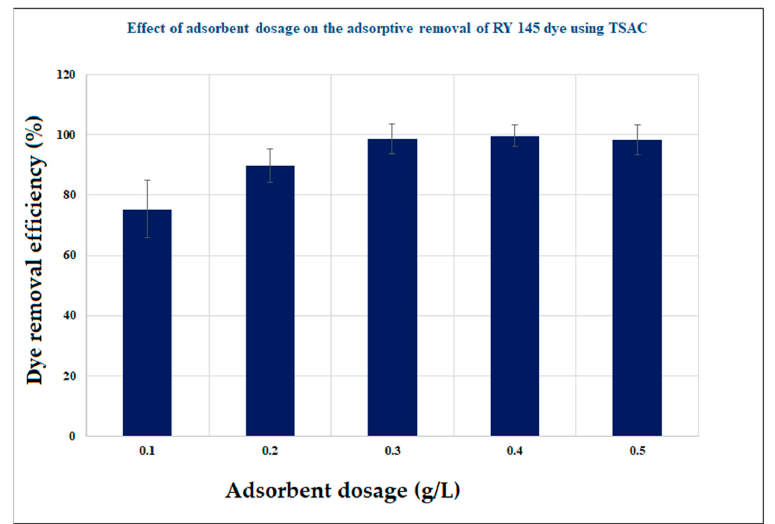
Figure 13. E ff ect of adsorbent dose on the adsorption of RY 145 dye on TSAC. ([RY 145 dye] = 0.3 g/L; Ph = 6; time = 120 min).